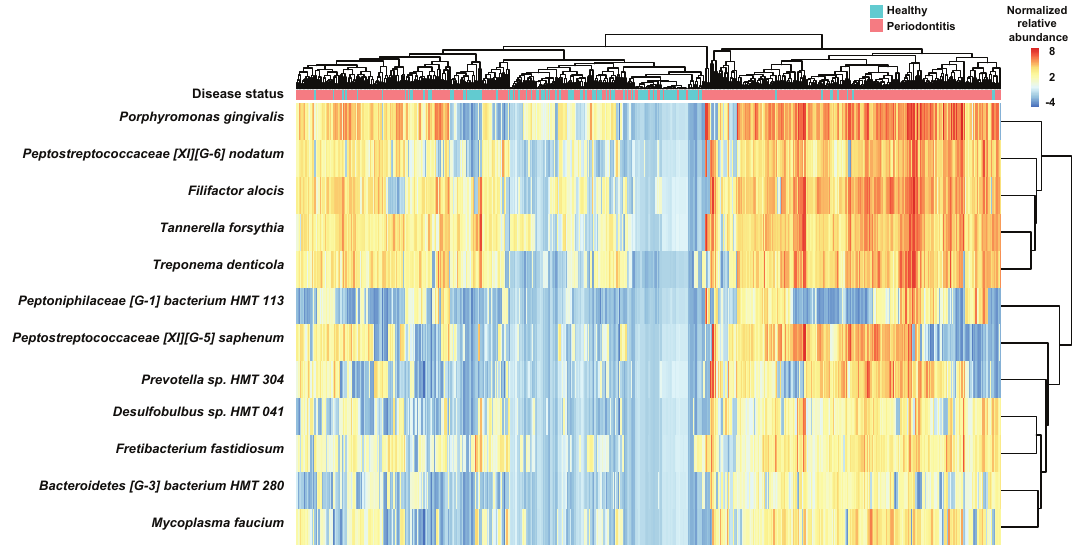
Figure 3. A heatmap of 12 highly correlated bacterial species. Pearson correlation was used to evaluate the association between bacterial abundances and clinical parameters (age, gender, PD, CAL, GI, and PI) and if the adjusted p-value was less than 0.001, the bacterial species was defined as a highly correlated bacterial species (Table S3). The heatmap was generated using the relative abundance normalized by centered log-ratio (CLR) methods (see supplementary